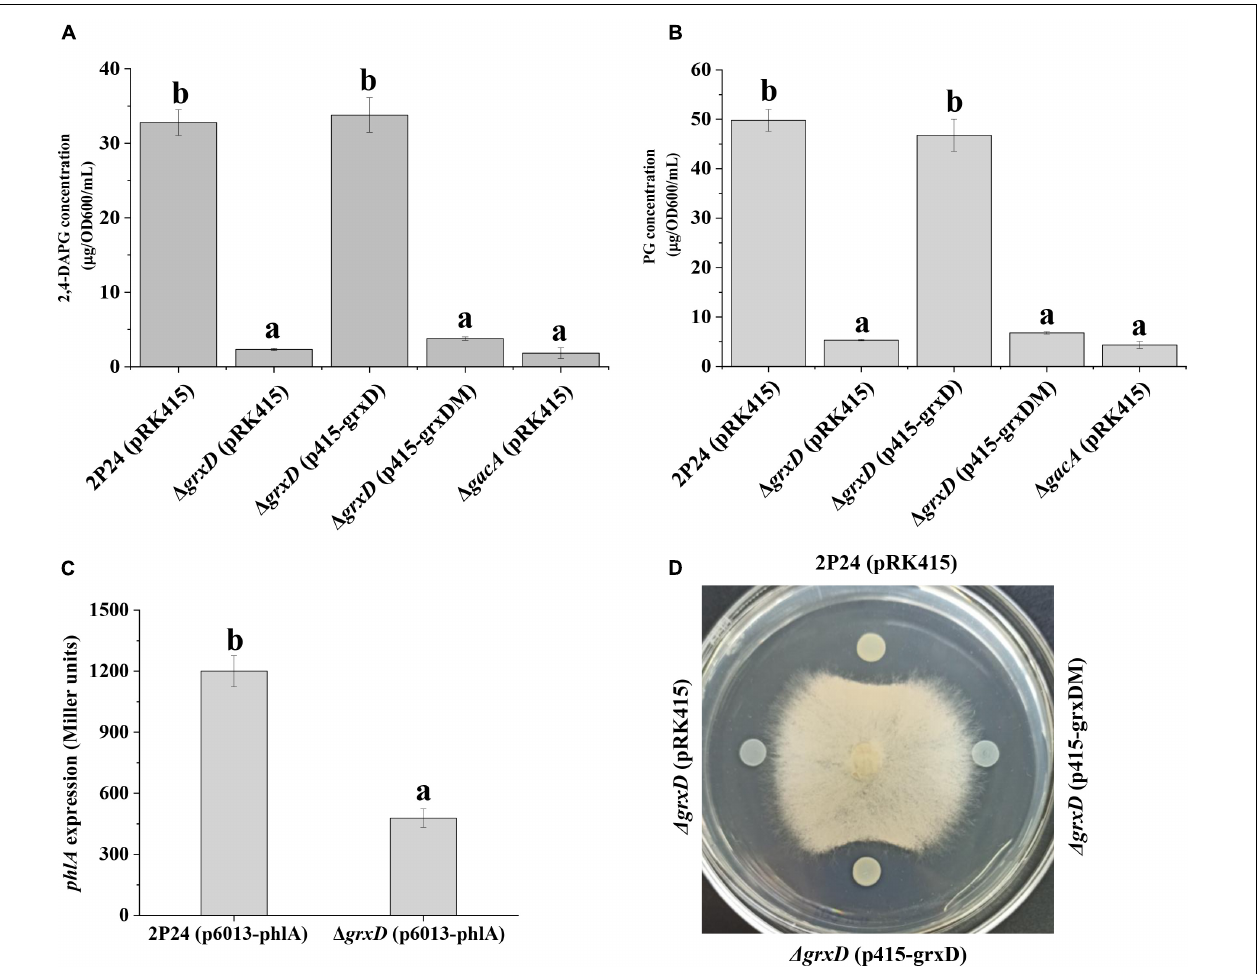
FIGURE 1 | The effect of grxD gene on 2,4-diacetylphloroglucinol (2,4-DAPG) biosynthesis (A) , phloroglucinol (PG) production (B) , phlA expression (C) , and antifungal activity (D) of Pseudomonas fluorescens 2P24. (A) High-performance liquid chromatography (HPLC) analysis of the concentration of 2,4-DAPG by strains 2P24 (pRK415), the grxD mutant (pRK415), the grxD mutant (p415-grxD), and the grxD mutant (p415-grxDM). (B) PG quantification from strains 2P24 (pRK415), the grxD mutant (pRK415), the grxD mutant (p415-grxD), and the grxD mutant (p415-grxDM) was measured by a colorimetric method. (C) The expression of phlA was positively regulated by GrxD. The β -galactosidase activity of the translational fusion phlA (cid:48) - (cid:48) lacZ was measured in strain 2P24 and its grxD mutant. (D) Inhibition of Rhizoctonia solani mycelial growth by 2P24 (pRK415), the grxD mutant (pRK415), the grxD mutant (p415-grxD), and the grxD mutant (p415-grxDM). All experiments were performed in triplicate, and letter represents significant differences between samples where p <